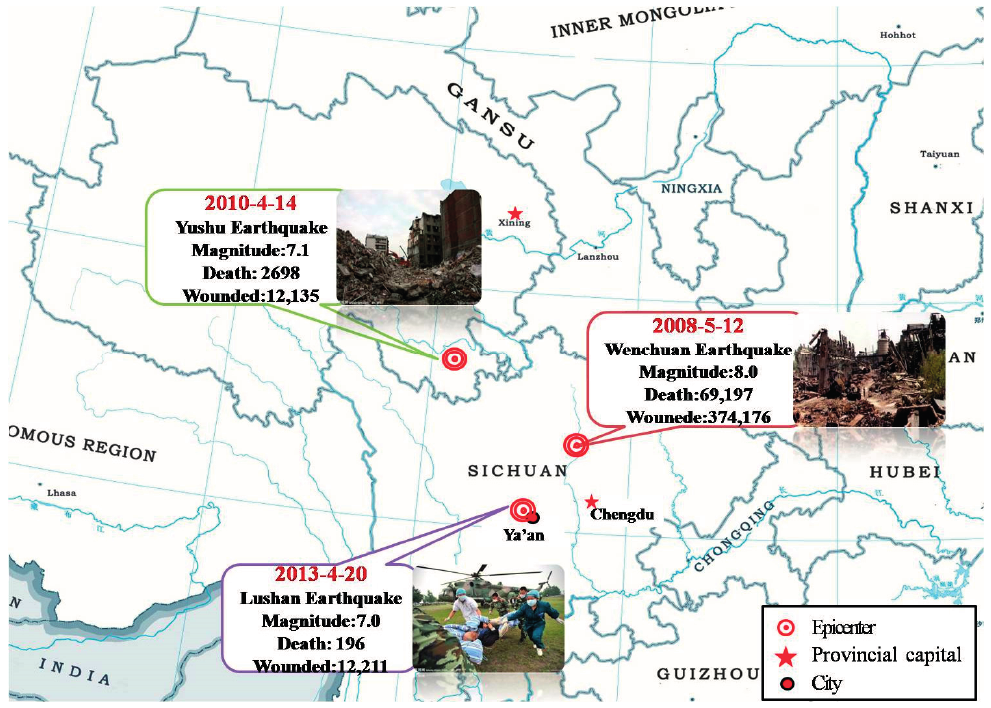
Figure 1. Overview of three catastrophic earthquakes in the past ten years in